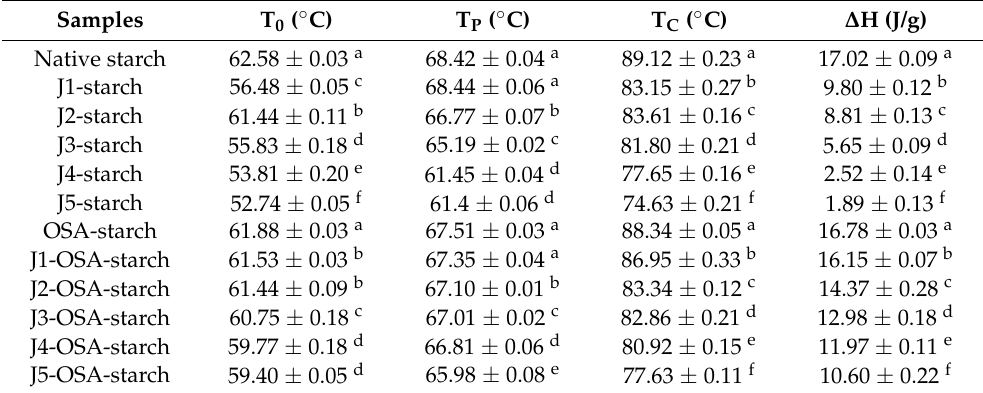
Table 3. DSC analysis of the native and treated corn starch samples.